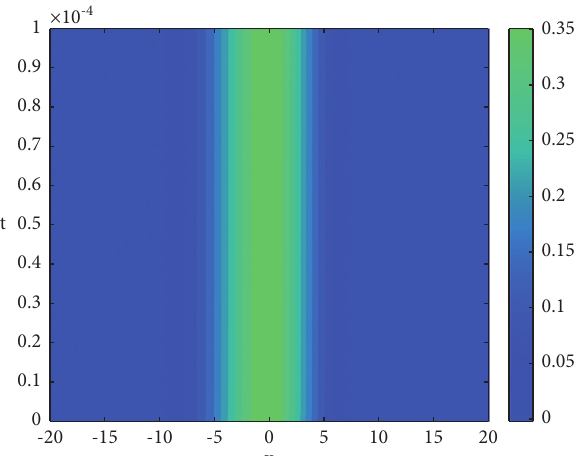
Figure 7: Contour of fractional spatial numerical solution u ( x,t ) at orders α � β � 0 . 6 , κ � 3 , δ � Figure 7 is the contour plot of solitary wave spatial solution against x and t .